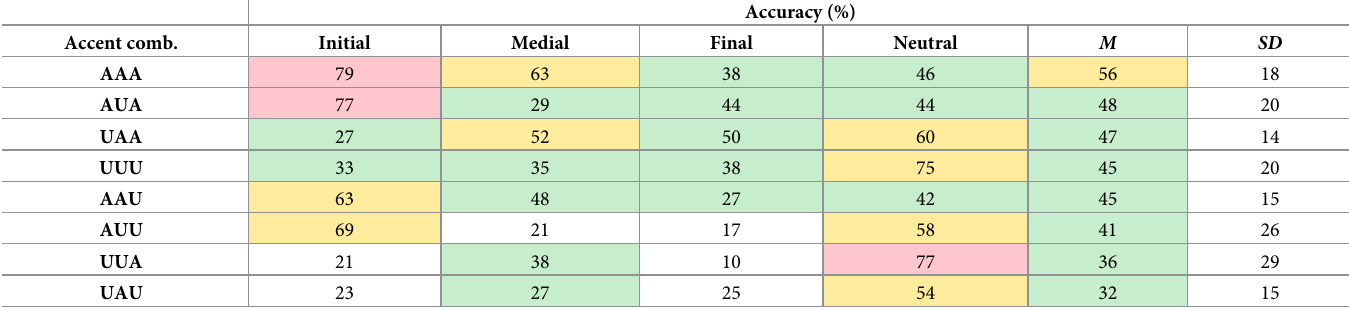
Table 2. Mean identification accuracy (chance = 25%) by accent combination and focus location. Accent combinations are in descending order of mean identification accuracy. Cell colouring signals the percentage of correct responses (25% < green < 50% < yellow < 75% < red) (colour online). Accent comb.